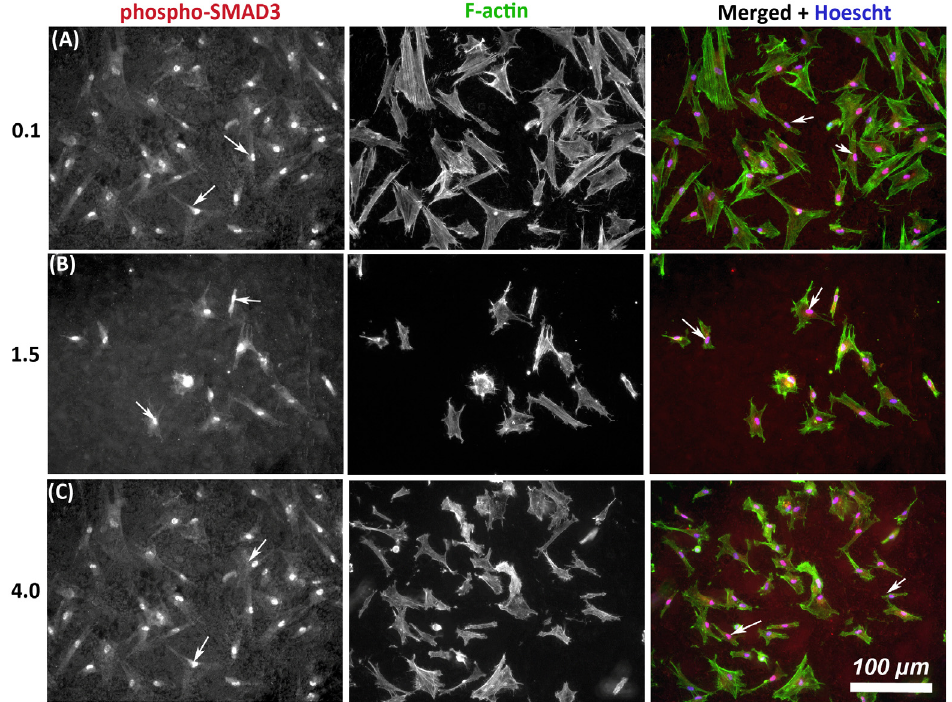
Figure 4. Influence of titanium substratum roughness on nuclear translocation of phospho-SMAD3 in HGFs. Cells were seeded on each topography and cultured for 24 h before being labeled with antibodies specific for phospho-SMAD3 which mediates transcriptional effects of TGF- β stimulation. Representative images are shown from 3 of the topographies employed, but nuclear transloca- tion of phospho-SMAD3 was evident in HGFs on all tested topographies. Cells were co-labeled with FITC-phalloidin for F-actin to show cell morphology. White arrows denote nuclear translocation of phospho-SMAD3. Images are shown of cells cultured on surfaces of R a = ( A ) 0.1, ( B ) 1.5, and ( C ) 4.0 demonstrating similar levels of nuclear translocation irrespective of substratum roughness.